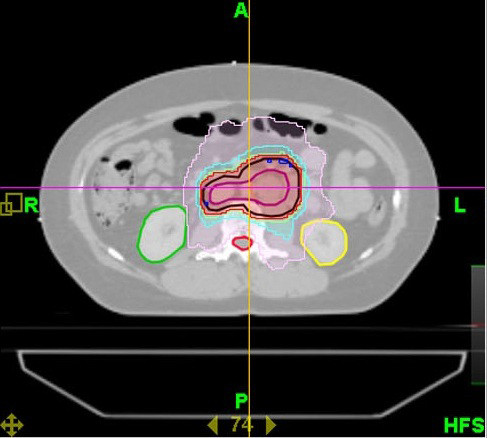
Axial view showing planning target volume and isodose distribution using TomoTherapy, sparing kidneys and spinal cord in the case of stage I seminoma.